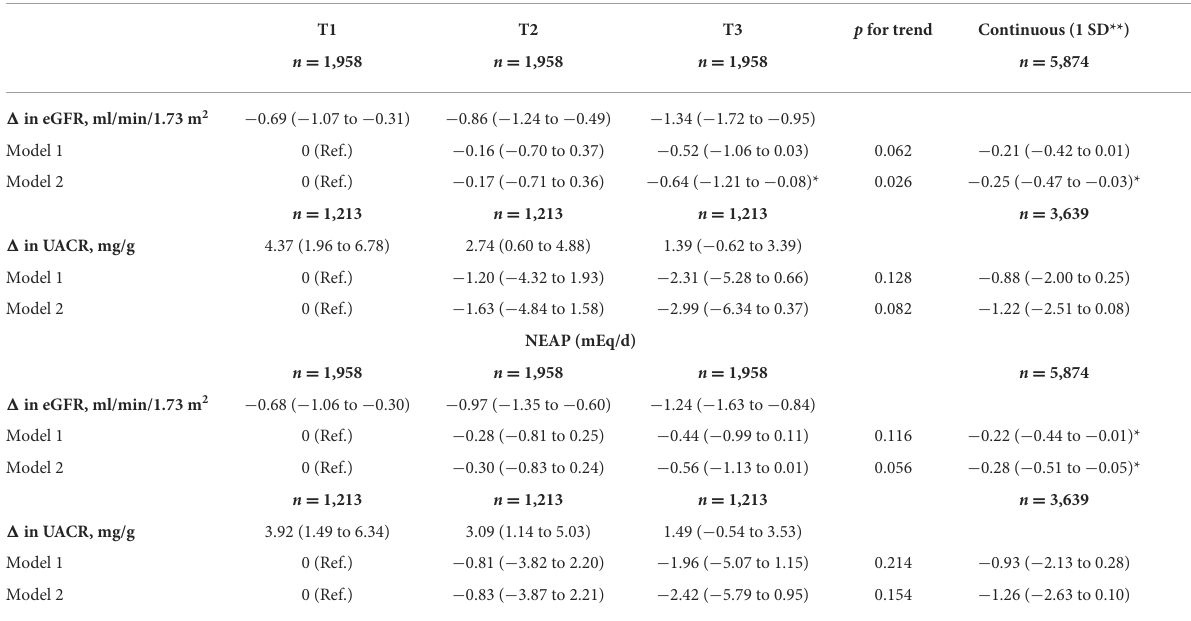
TABLE 2 Multivariable-adjusted β -coefficients and 95% CI of 1-year changes in eGFR (ml/min/1.73 m 2 ) or in UACR (mg/g) across tertiles and per 1-SD increment of baseline PRAL and